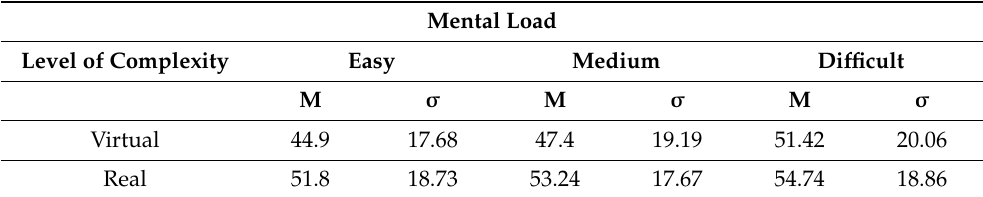
Table 1. Descriptive statistics (M = mean; σ = standard deviation) of mental load by level of complexity and type of presentation (real or